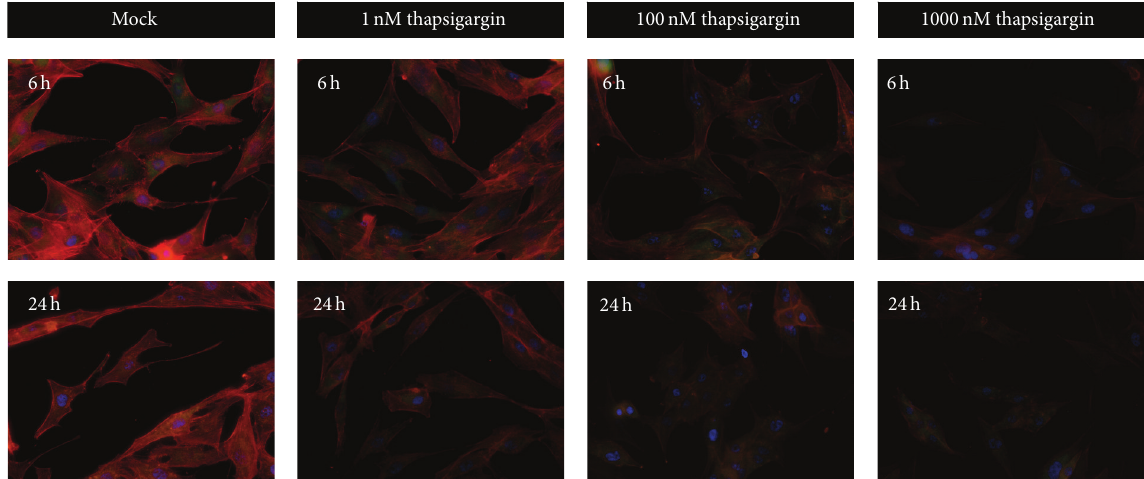
Figure 2: Thapsigargin impairs actin cytoskeleton organizations in A549 cells. The reductions of F-actin fibers by thapsigargin (1nM, 100nM, and 1 𝜇 M for 6 and 24 h) treatments were shown by immunostaining. Red fluorescence is indicated by Rhodamine-phalloidin probes, green by RhoA antibody, and blue by DAPI.